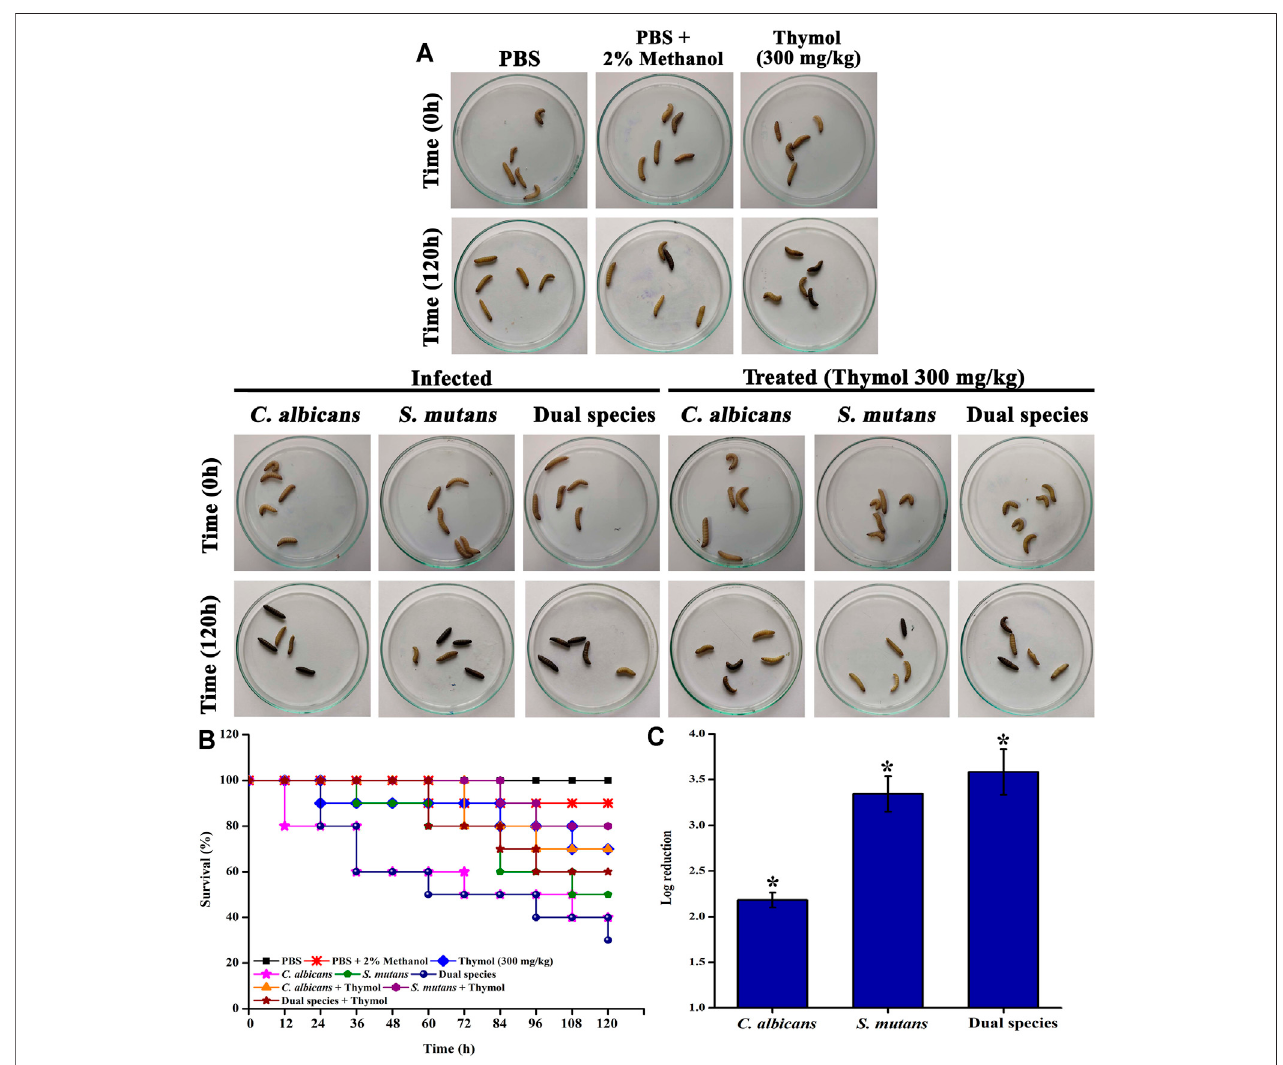
FIGURE 8 | In vivo anti-infective ef fi cacy of thymol against single and dual species of C. albicans and S. mutans in the G. mellonella model system. (A) Representative image displaying the survival status of larvae at time 0 h and time 120 h in different groups. Thymol at 300 μ g/ml concentration was administered to checkthetoxic effect.Nosigni fi cantreductioninmortality wasobserved. Hence, thymol at thetested concentrationwasfoundtobe nontoxic.Infectedgroupsreceived respectivecultures,andthetreatedgroupsreceivedbothcultureandthymolat300 μ g/mlconcentration.Larvaethatturnedtocompleteblackandnoresponseto physical stimulus were considered to be dead. (B) The Kaplan − Meier survival plot displaying the survival of G. mellonella under the in fl uence of various treatments. Thymol at 300 mg/kg was found to be nontoxic to the G. mellonella larvae. C. albicans and dual species infection drastically reduced the survival rate, whereas thymol treatment rescued G. mellonella from infection. (C) Reduction in the internal microbial burden due to the anti-infective potential of thymol. Error bars represent standard deviations from the mean and * indicates signi fi cance p < 0.05.